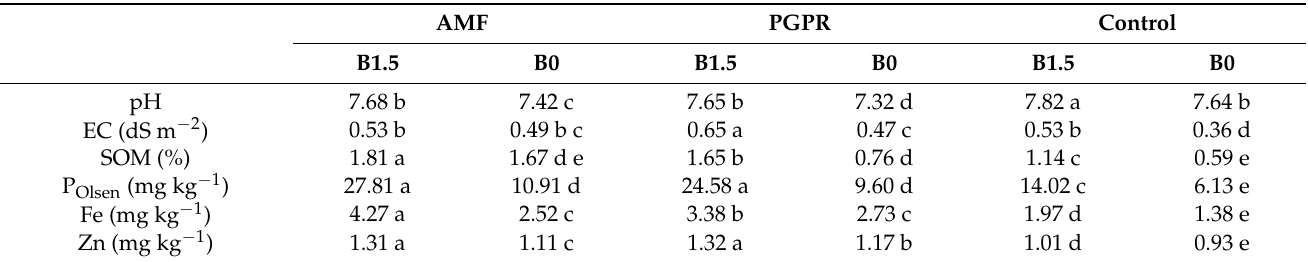
Table 3. Interaction effects of biochar amendment and microbial inoculation on pH, EC, organic matter content, and levels of P, Fe, and Zn in rhizosphere